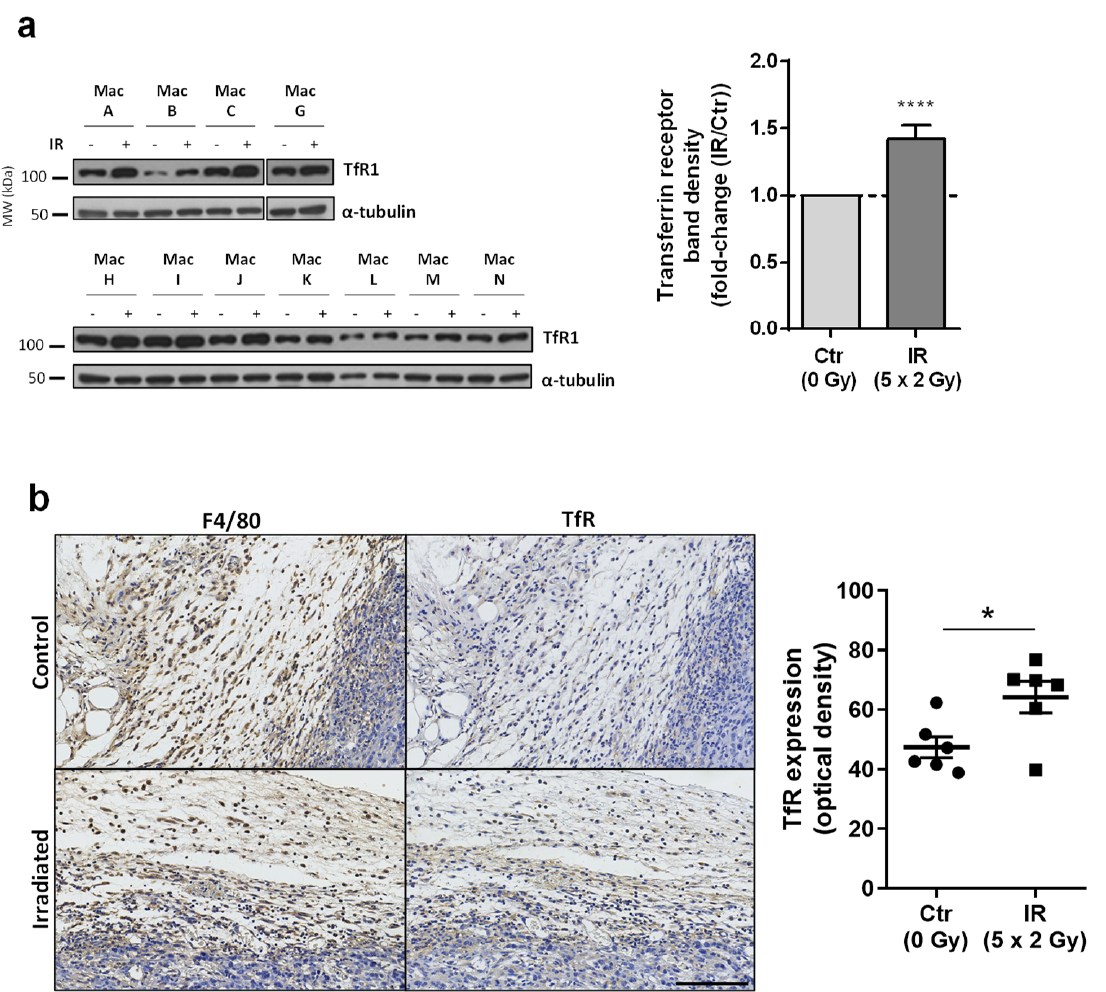
Figure 4. TfR1 is upregulated in macrophages irradiated in vitro and in vivo. ( a ) TfR1 expression was evaluated by Western blot in irradiated macrophages and compared with non-irradiated ones ( n = 11). The graph depicts the quantification of TfR1 band intensity, normalized to α -tubulin staining. Data are presented as the mean ± SEM (**** p < 0.0001). A one-sample t -test was used for statistical analysis. ( b ) Representative images of immunohistochemistry for F4/80 (macrophage marker) and TfR1 in irradiated and non-irradiated mouse breast peritumoral tissue. Scale bar = 100 µ m. Semi-quantitative analysis of macrophage TfR1 expression in irradiated (IR, n = 6) and non-irradiated (Ctr, n = 6) animals is depicted. Values represent the mean optical density of TfR1 staining of a minimum of 100 macrophages per animal. Data is presented as the mean ± SEM (* p < 0.05) and each symbol represents one animal. A one-sample t -test was used for statistical analysis. The whole blots (uncropped blots) showing all bands with all molecular weight markers on the Western are provided in the Supplemental Materials.